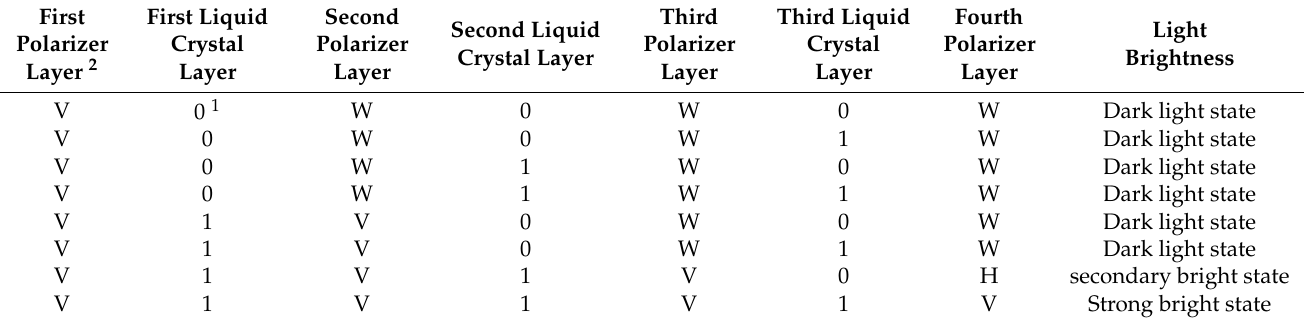
Table 1. Spin light mode, output light state, and light brightness comparison table.